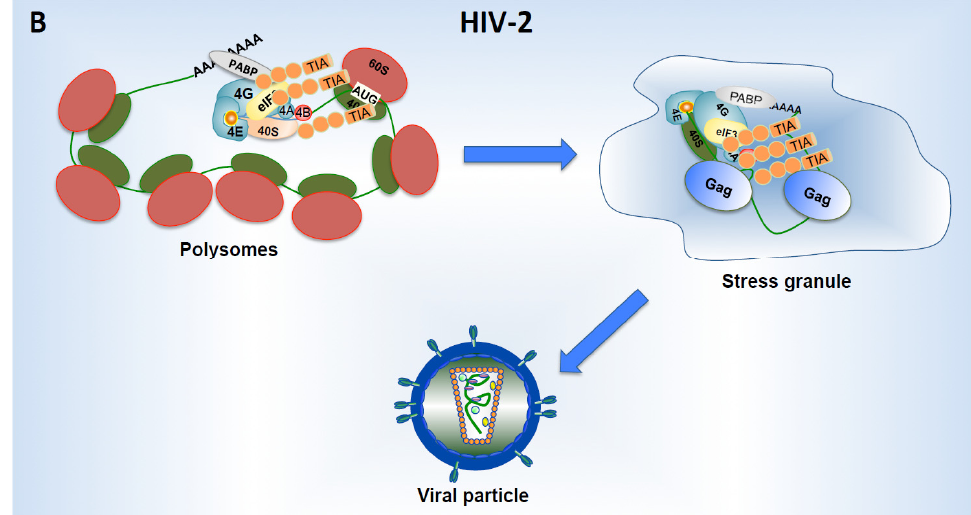
Figure 3. RNA granules assembled during HIV replication. ( A ) Polysome association of HIV-1 unspliced mRNA requires its previous assembly in DDX3-dependent granules together with eIF4GI, PABPC1 and probably other, yet, unidentified cellular proteins.